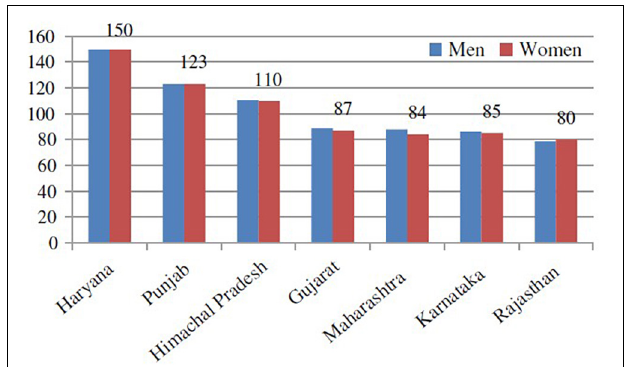
FIGURE 2 | Wage rate obtained under MGNREGA (in Indian Rupees) across some selected Indian states. Adopted from Kumar